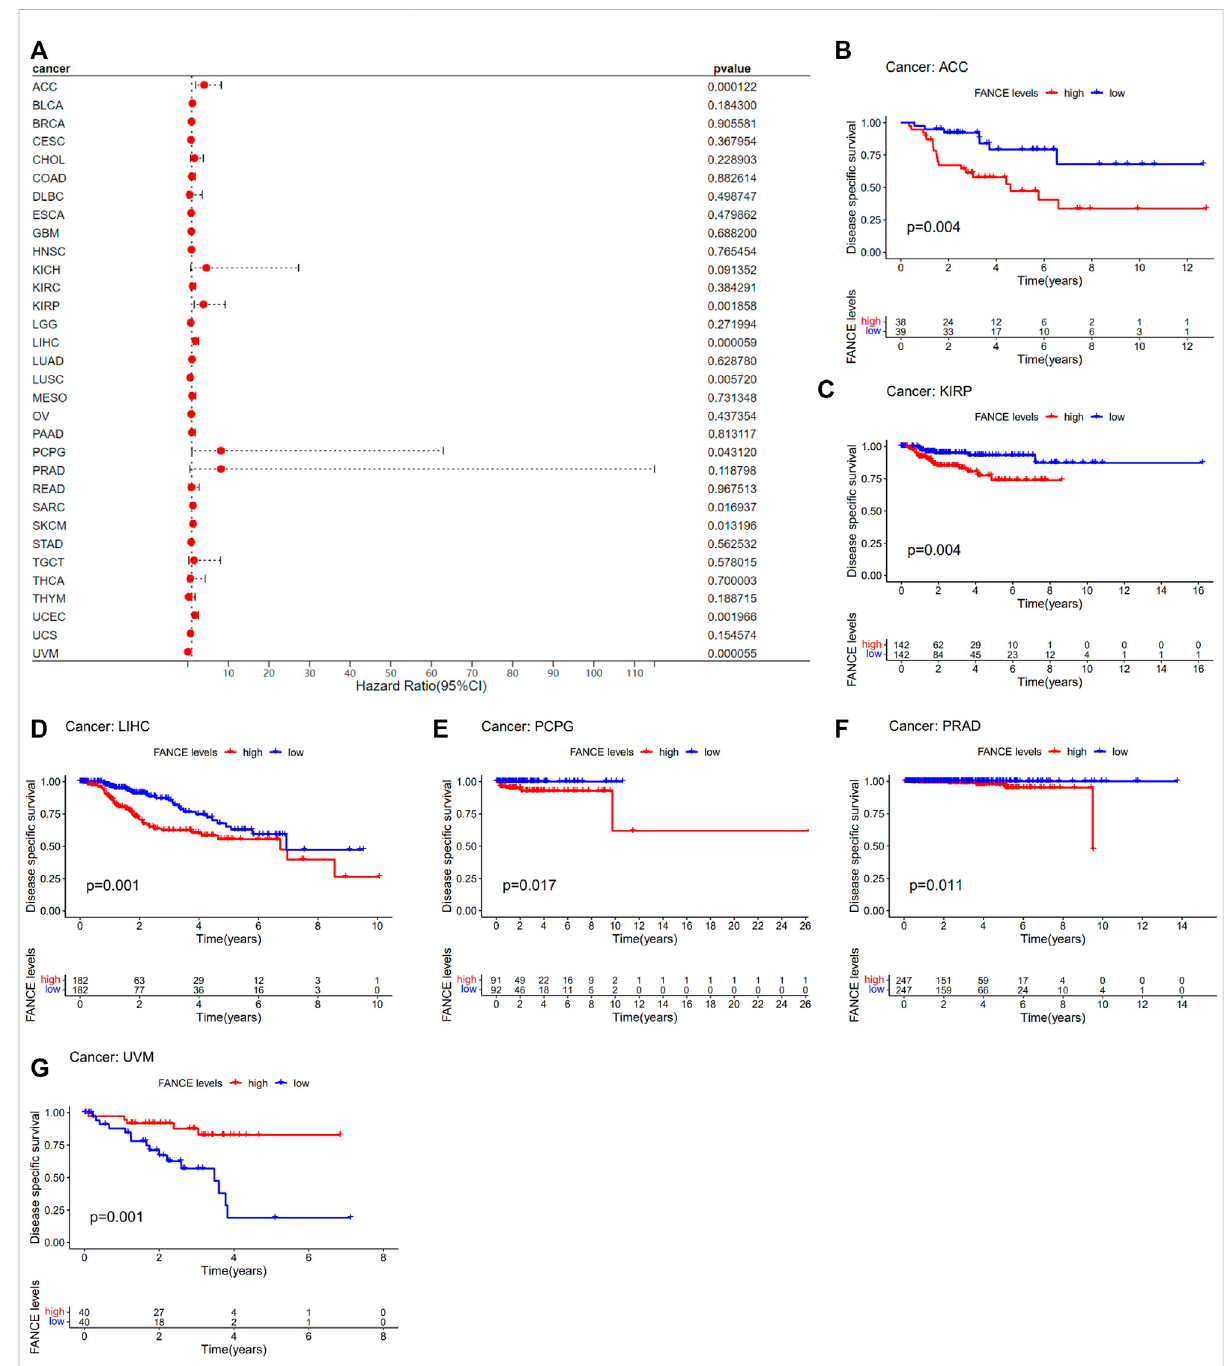
FIGURE 5 Correlation between FANCE expression and disease-speci fi c survival (DSS) using data from the TGCA database. (A) Forest plot of FANCE expression and DSS in 32 cancers. (B – G) The Kaplan – Meier survival analysis for FANCE expression and DSS in six cancers. * p < .05; ** p < .01; and *** p <